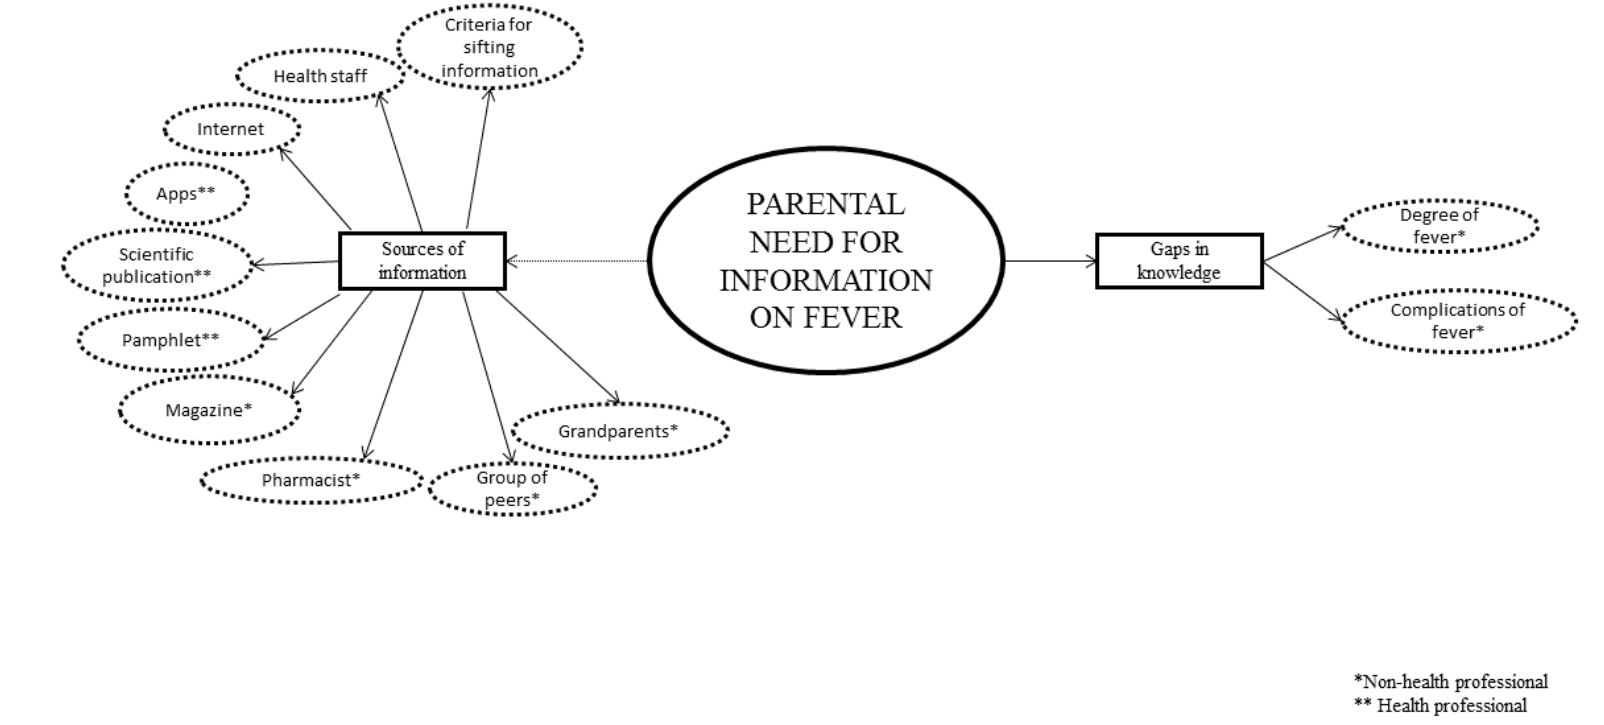
Figure 3. The need for information on fever perceived by Figure 3. T he need for information on fever perceived by parents. 16